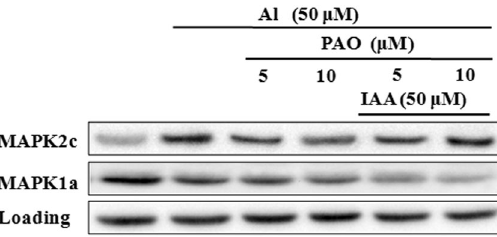
Figure 10. Expression of MAPK2c and MAPK1a in wheat. Western blot was used to assess MAPK2c and MAPK1a protein expression in root apexes (0–20 mm) of wheat lines ET8. Seedlings were exposed to 0.5 mM CaCl 2 solution (pH 4.5) containing other chemicals: 0 μ M AlCl 3 (CK), 50 μ M AlCl 3 , 50 μ M AlCl 3 and 5 (or 10) μ M PAO, 50 μ M AlCl μ M IAA and 5 (or 10) μ M PAO for 24 3 and 50